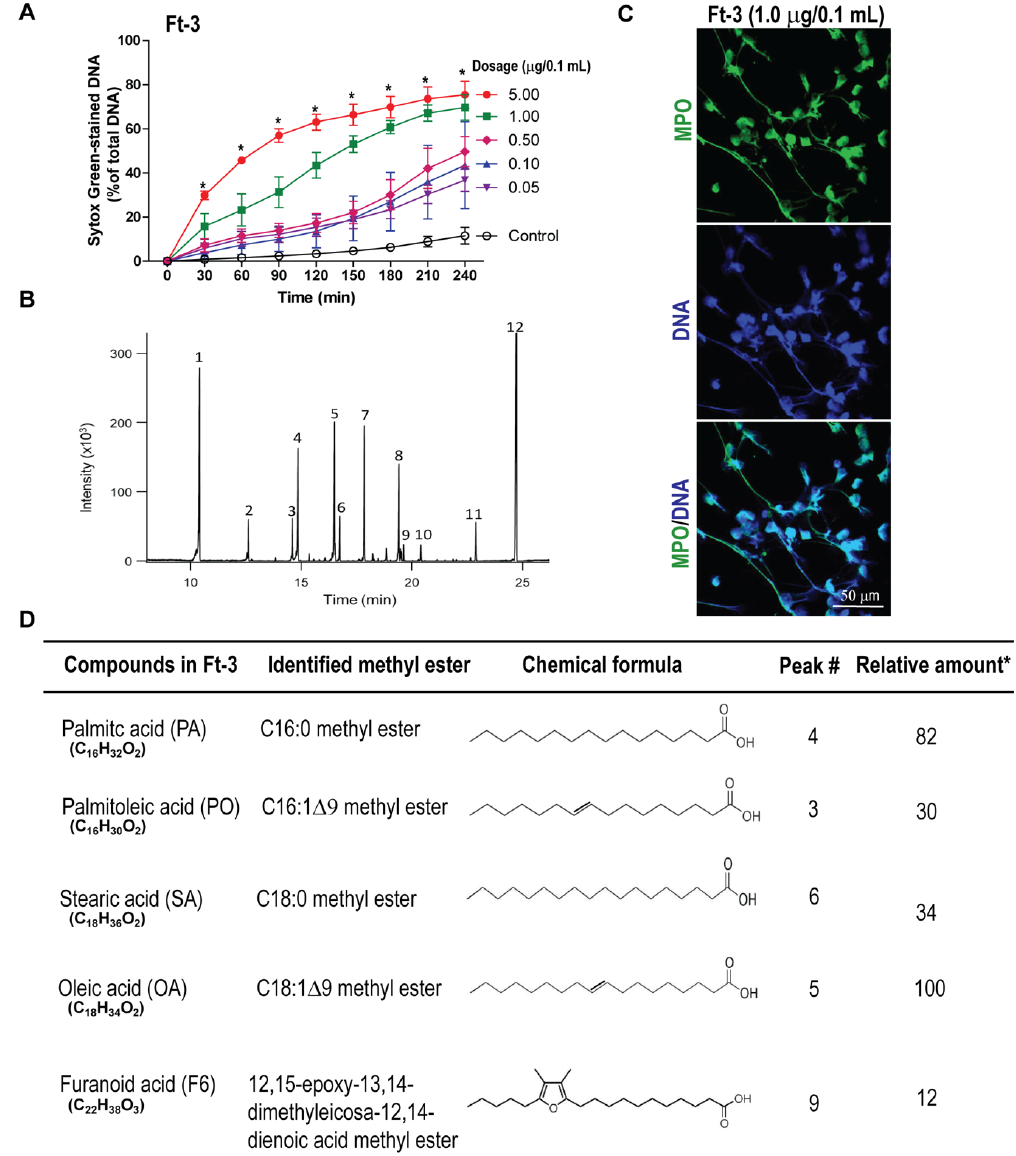
Figure 1. Lipid fraction Ft-3 from total lipid extract of catfish epidermal gel secretion induces neutrophil extracellular trap (NET) formation (NETosis) in human neutrophils. ( A ) SytoxGreen-based NETosis kinetics suggest that lipid fraction 3 (Ft-3), isolated from the dermal gel secretion of the catfish, induces NETosis in a dose-dependent manner ( n = 5, * p -value < 0.05 comparing with control; two-way analysis of variance (ANOVA) with Bonferroni’s multiple comparison post-test); ( B ) Confocal images of neutrophils treated with Ft-3 showing DNA-fibers (blue) colocalized with MPO (green), confirming the formation of NETs by this lipid fraction ( n = 4; scale bar, 50 µm). See Supplementary Figure S1 for the control NETosis induced by typical agonists phorbol 12-myristate 13-acetate (PMA) and A23187, and confocal images; ( C ) Gas chromatography–mass spectrometry (GC-MS) profile of the methylated fraction present in Ft-3; ( D ) Relative amounts of the studied lipid compounds that were present in Ft-3 fraction (chemical structures shown as the free acids), as determined by GC-MS. See Supplementary Figure S2 for confirmation of the compounds listed in ( D ).